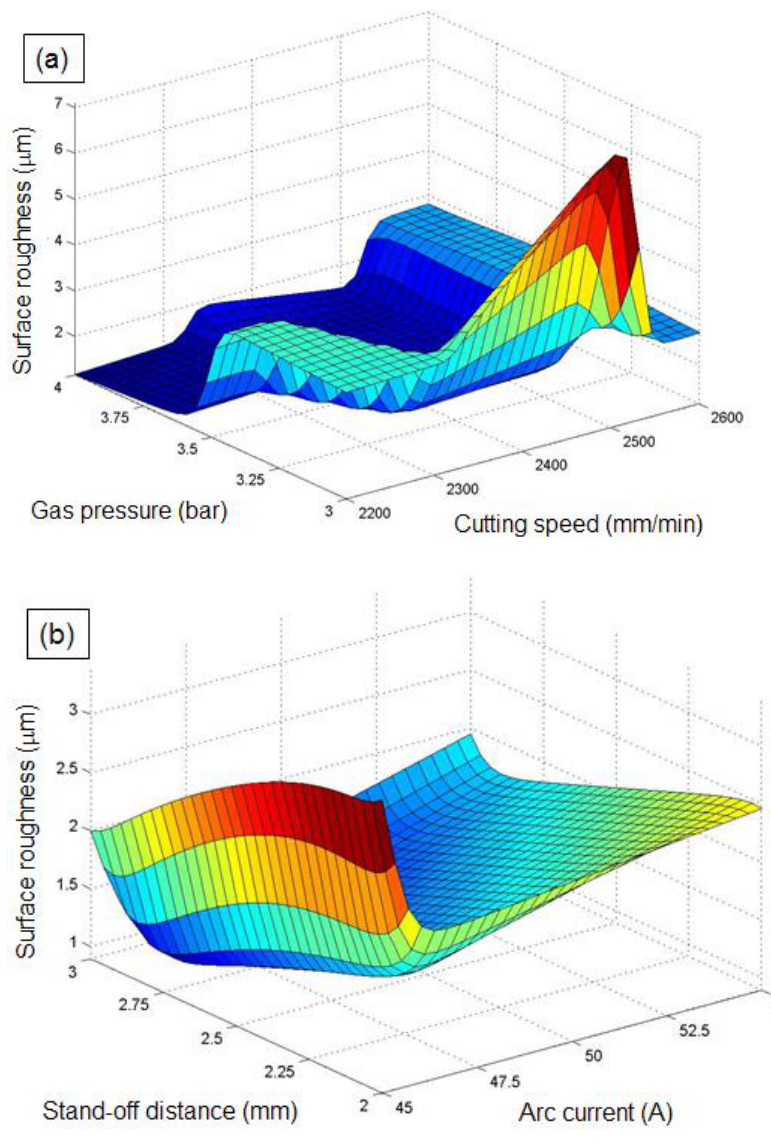
Figure 11. Influence of PAC parameters on Ra: ( a ) influence of cutting speed and gas pressure on Ra , and ( b ) influence of arc current and stand-off distance on Ra .